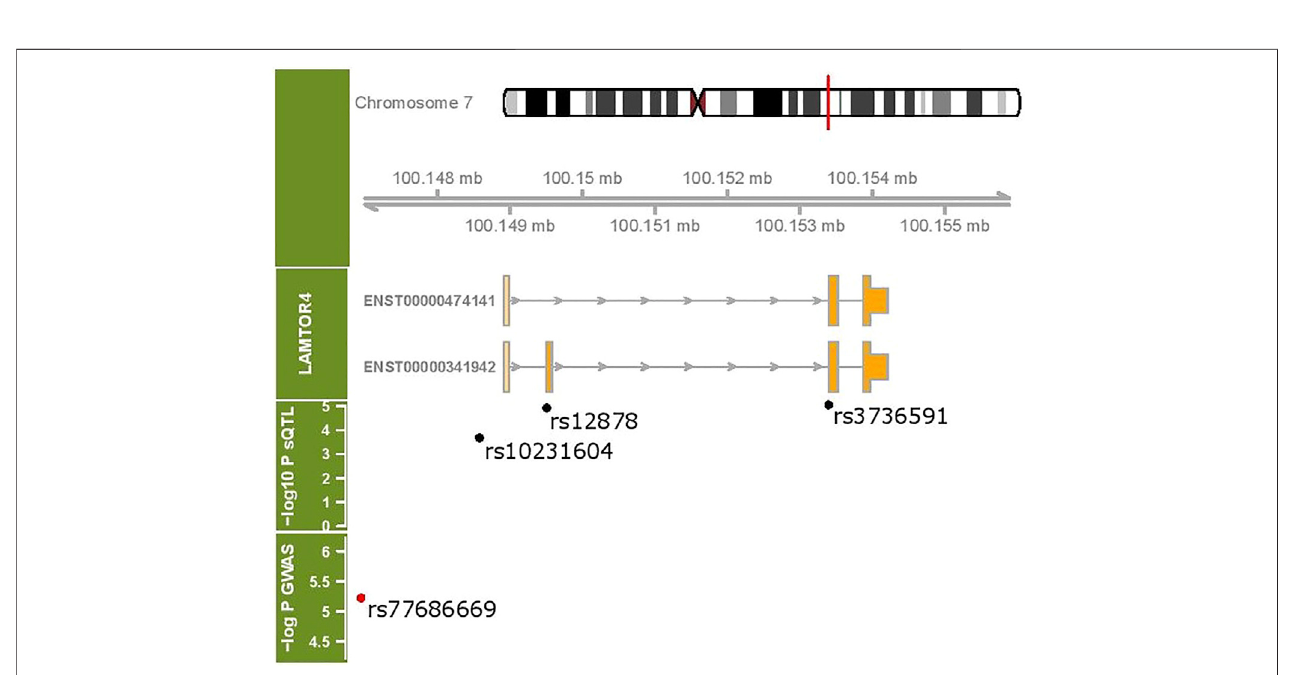
FIGURE 5 | LAMTOR4 genomic region (chr 7:100148907- 100155944). Two transcripts under sQTL regulation are shown. The location of three sQTL variants in fl uencing the expression of the LAMTOR4 transcripts are labeled. Shown in red is a GWAS-identi fi ed SNP associated with venous thromboembolism.